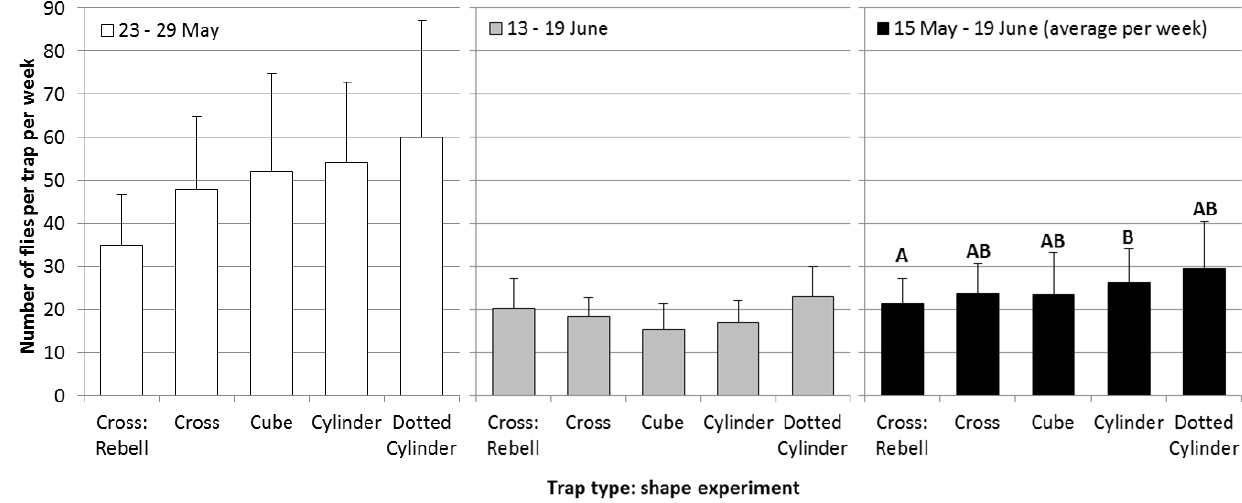
Figure 6. A comparison of differently-shaped trap types on the numbers of captured cherry fruit flies per week (+SE) during the second week of experiments (white bars), the fifth week of experiments (grey bars) and during the whole experimental period (black bars; average show significant